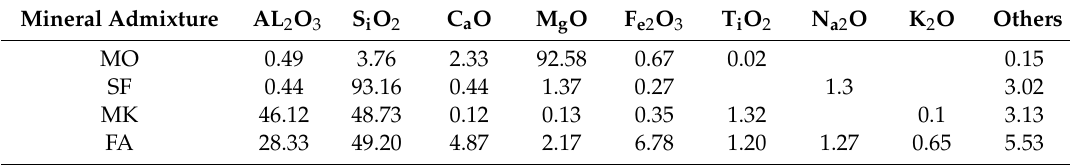
Table 1. The chemical components of raw material powders (Mass fraction, %). Mineral